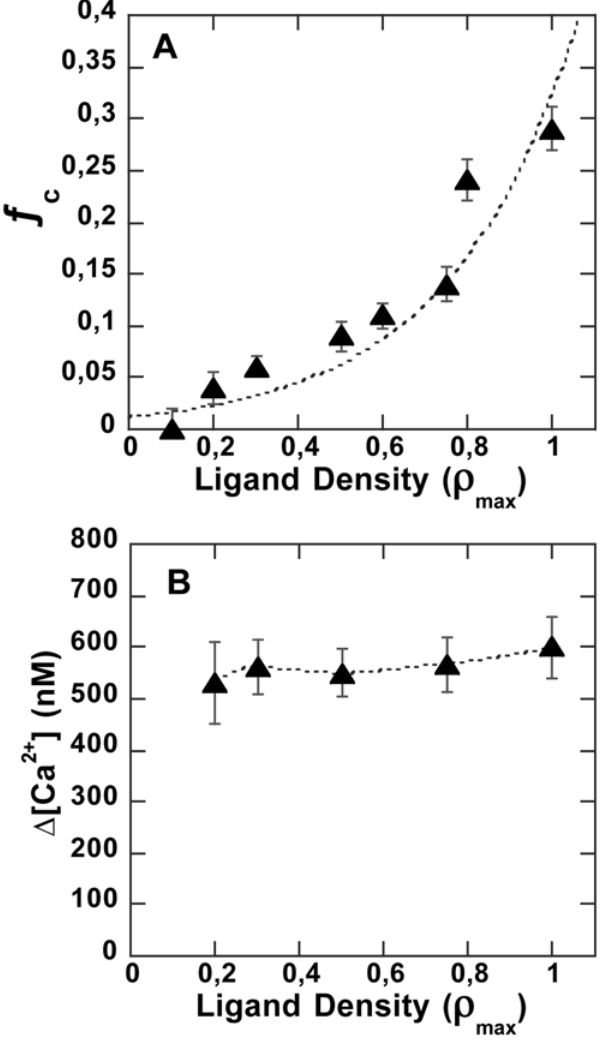
Figure 7. Anti-CD3 particle surface density variation. (A) Fraction of particle-bearing cells as a function of anti-CD3 ligand density on the particle surface. (B) Maximum calcium concentration induced by particle contact as a function of particle grafting density. Conditions as in fig. 2.